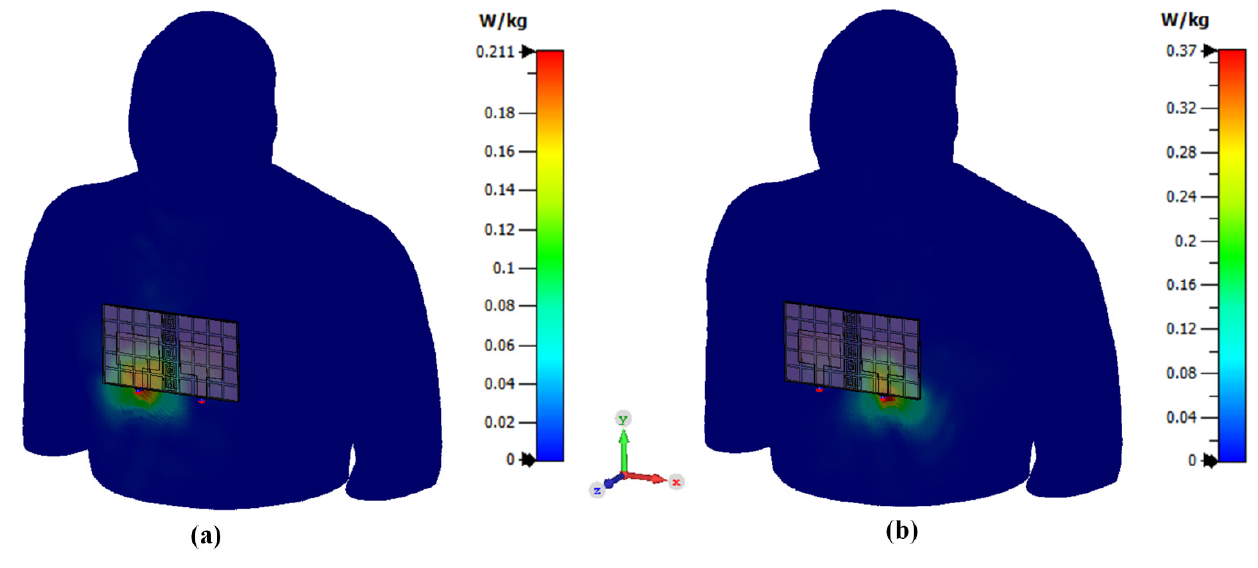
Figure 18. SAR analysis for 1g tissue. ( a ) antenna 1, ( b ) antenna 2.